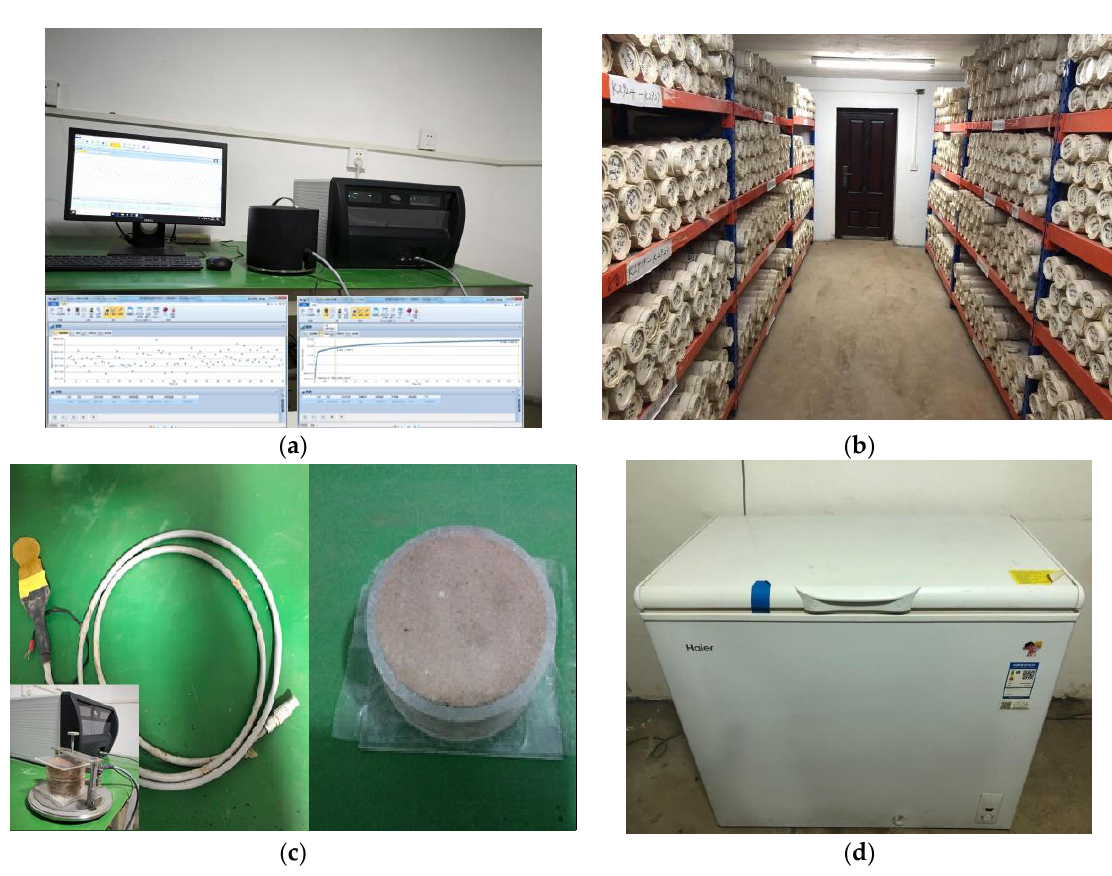
Figure 3. Schematic of thermal conductivity test system. ( a ) Thermal conductivity analyzer; ( b ) soil sample library; ( c ) specimen and Kapton probe; ( d ) freezing cabinet.